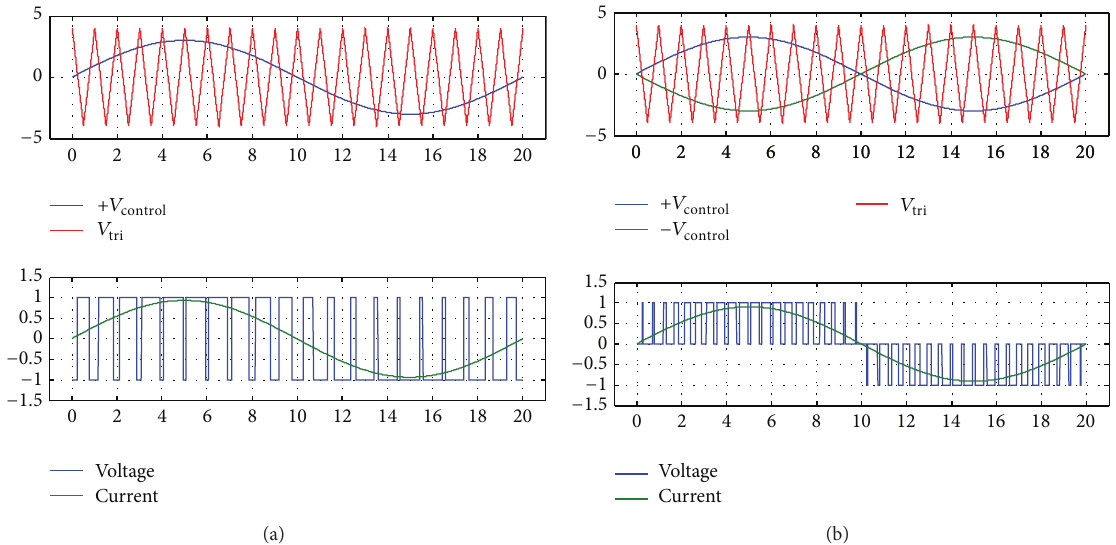
Figure 11: Switching technology (a) Unbipolar Voltage type of PWM—two level Output Voltage, (b) Bipolar Voltage type of PWM—three level Output Voltage.